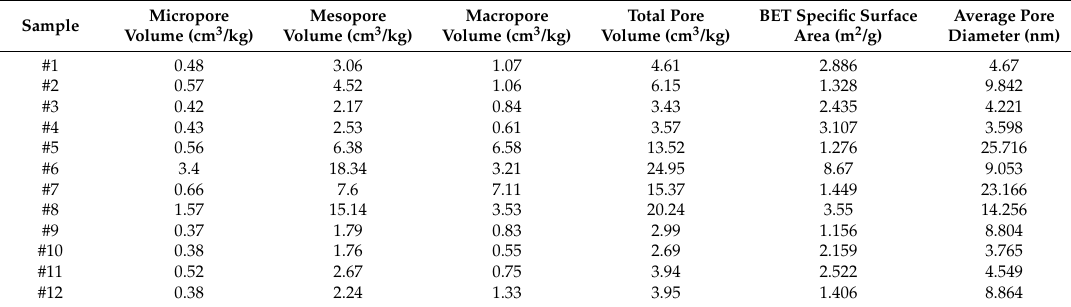
Table 3. Pore structure parameters of the Bakken